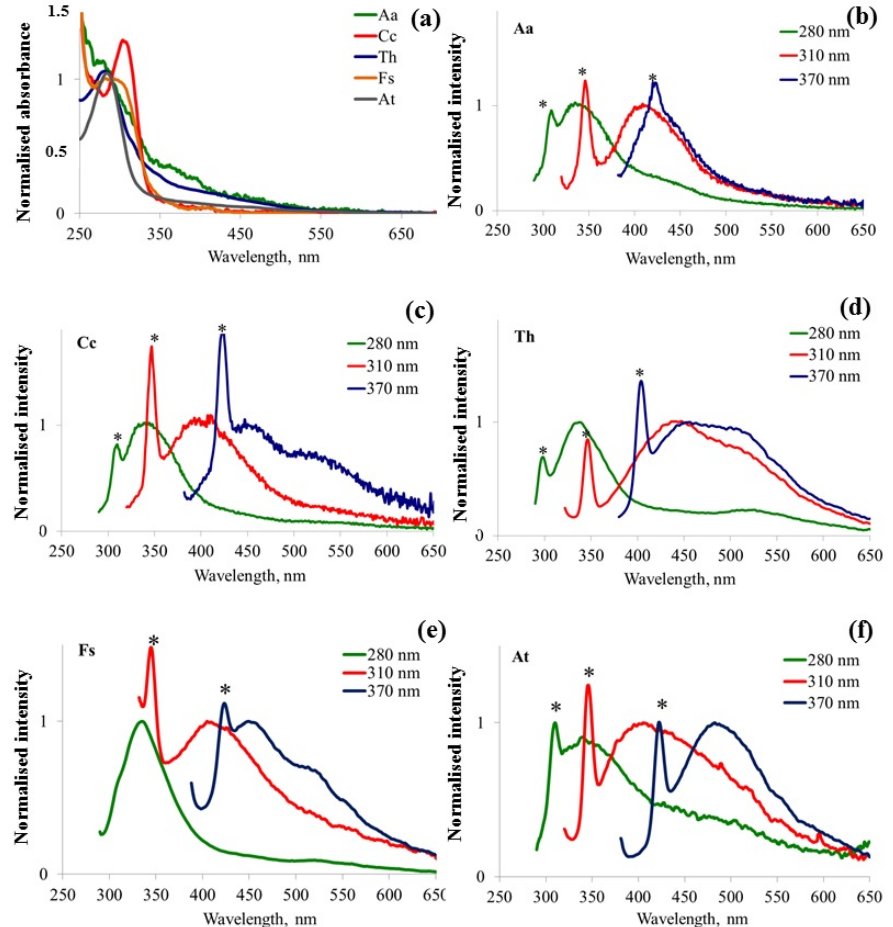
Figure 4. Absorption spectra normalized at absorbance taken at 280 nm ( a ) and fluorescence emission spectra of the fungal samples grown on liquid medium: ( b ) emission spectra of Alternaria alternata (Aa); ( c ) emission spectra of Cladosporium cladosporioides (Cc); ( d ) emission spectra of Trichoderma harzianum (Th); ( e ) emission spectra of Fusarium solani (Fs); and ( f ) emission spectra of Aspergillus terreus (At). The fluorescence emission spectra were measured with excitation at 280, 310 or 370 nm, and then normalized by emission intensity at maximum. The star indicates the position of water Raman scattering band.